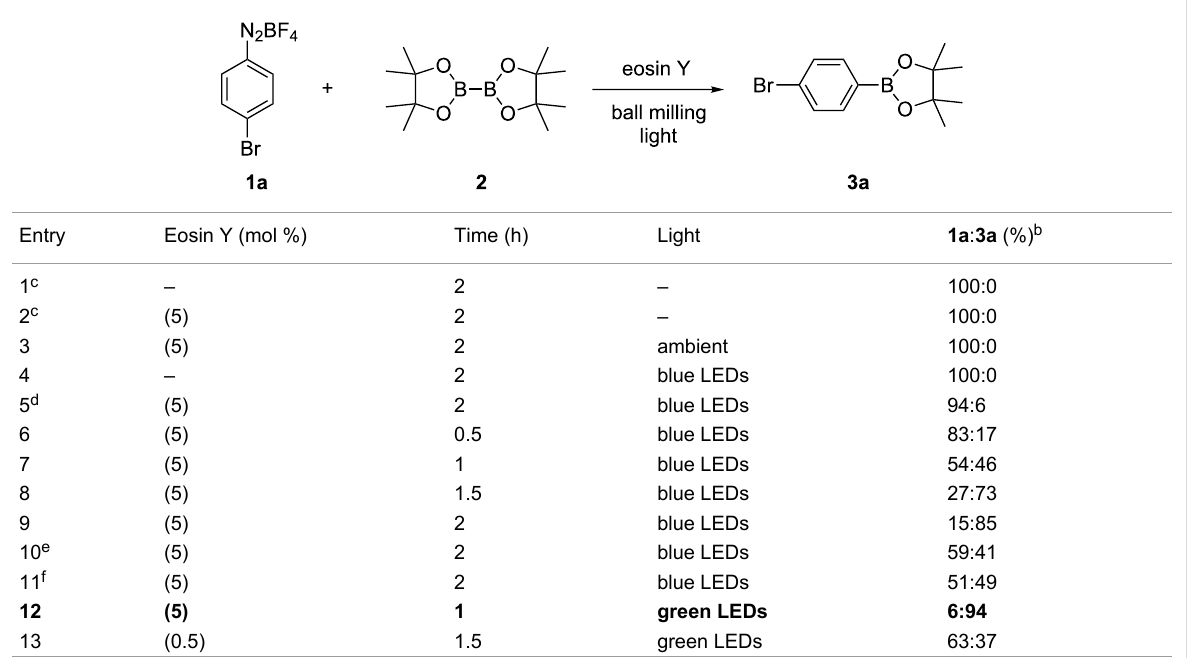
Table 1: Screening of the reaction conditions. a